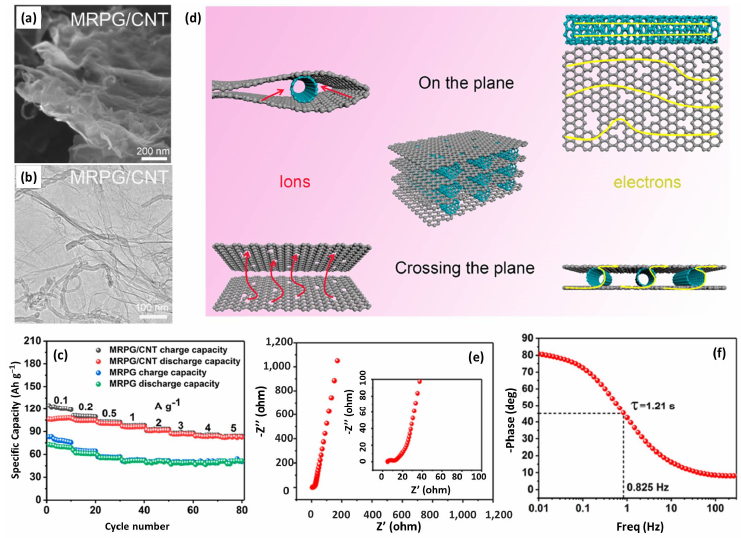
Figure 7. ( a ) SEM and ( b ) TEM images of MRPG/CNT; ( c ) Rate performanceof MRPG and MRPG/CNT; ( d ) Schematic illustration of the ion channels and electron channels in MRPG/CNT; ( e ) Nyquist impedance and ( f ) Bode plots of MRPG/CNT//MRPG/CNT LIC. Reproduced with permission from Ref. [71]. Copyright 2021, American Chemical